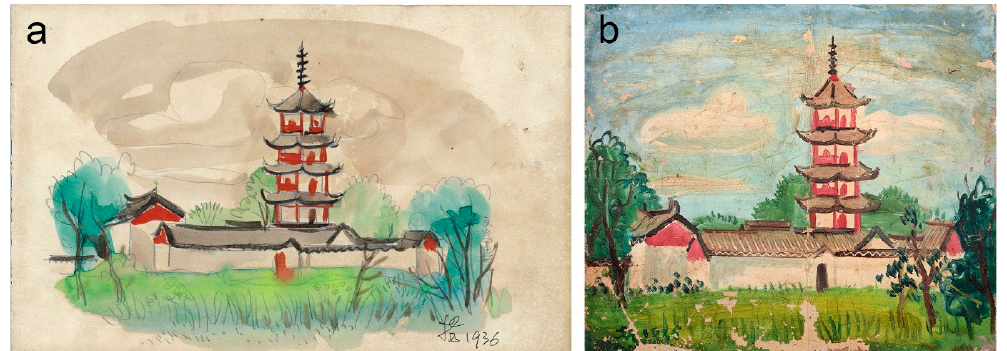
Figure 15. ( a ) Liu Kang, Pagoda , 1936, watercolour, 28.5 × 18 cm. ( b ) Liu Kang, Pagoda , 1936, oil on canvas, 45 × 55 cm. Liu Kang family collection. Images courtesy of the Liu family.